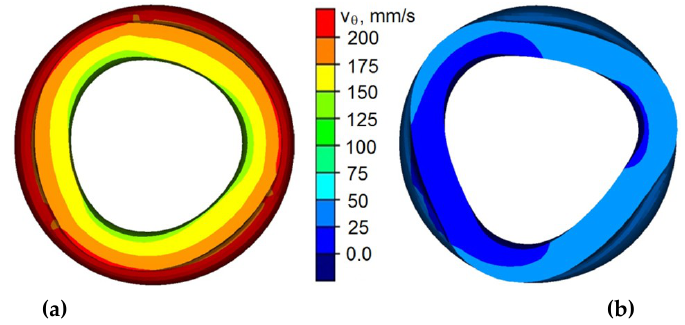
Figure 7. Distribution of the peripheral speed of the formed element: ( a ) in the stable phase of the process; ( b ) during uncontrolled